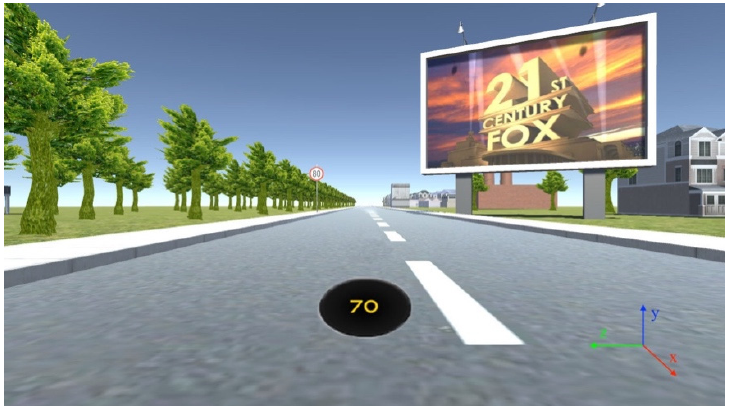
Figure 2. A screenshot showing the first-person perspective driving in the driving simulator. The right bottom corner 3D axis legend is added separately.